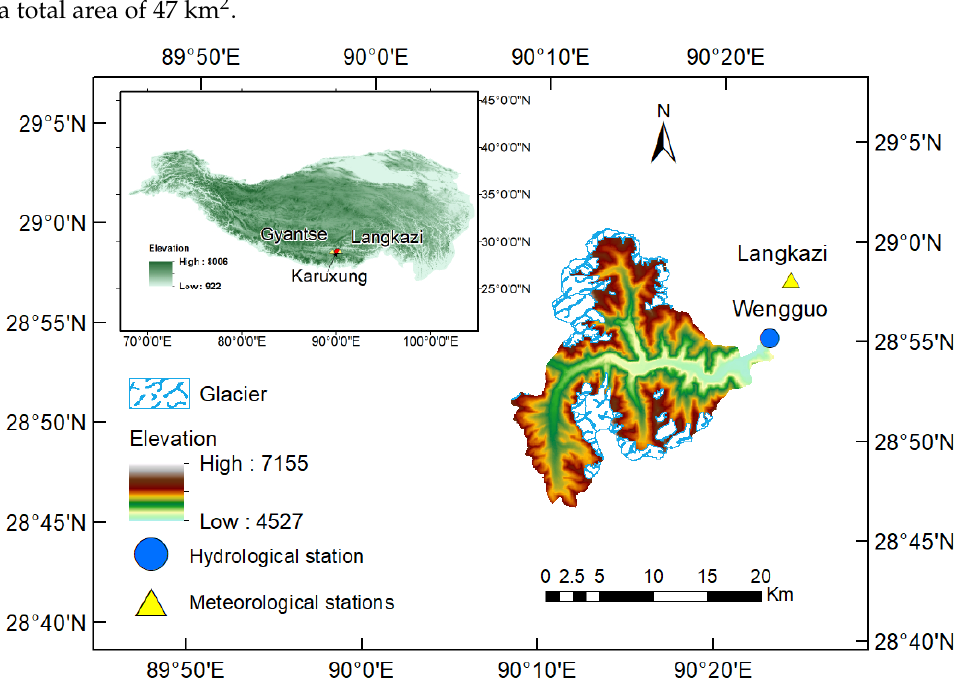
Figure 1. Location and topography of the study area (i.e., the Karuxung